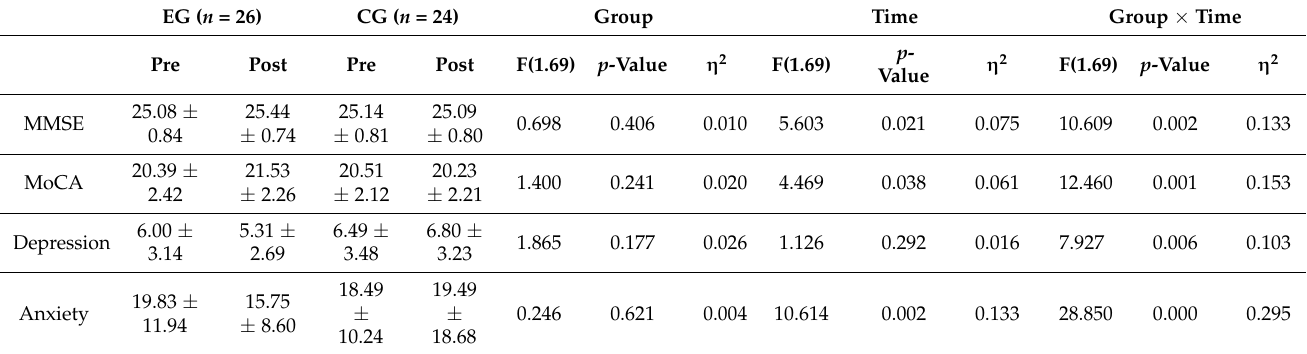
Table 2. Effects of the cognitive stimulation program on cognitive performance, cognitive impairment, anxiety and